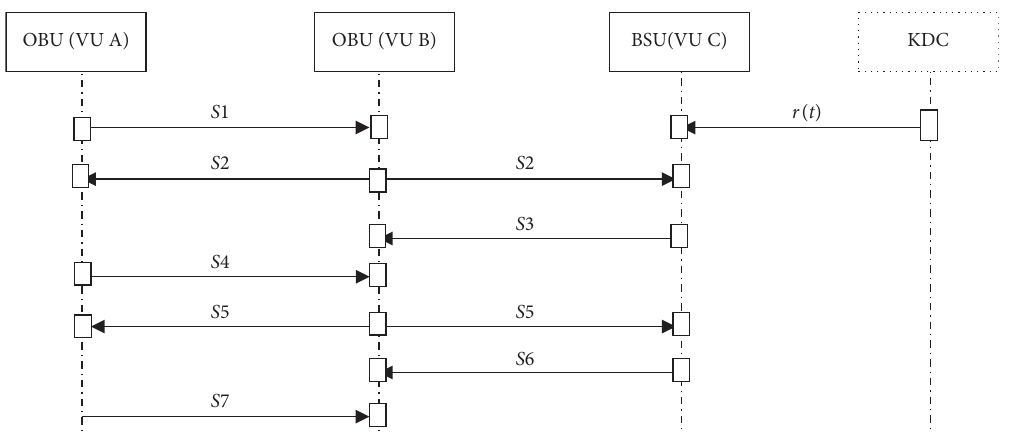
Figure 5: Refreshment time of TAD-HOC.